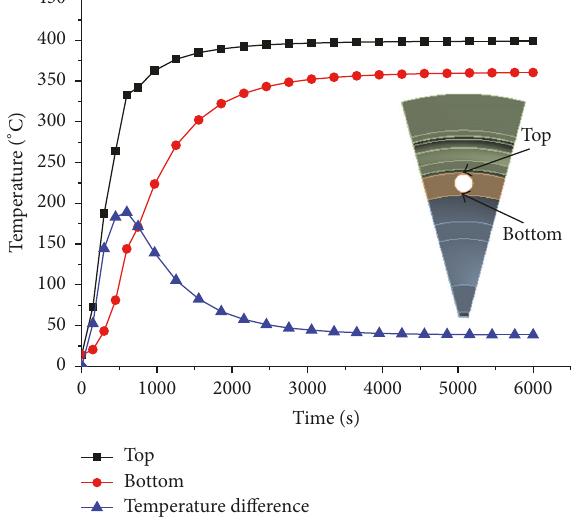
Figure 12: Temperature variation of the 1st turbine tie rod hole during start-up